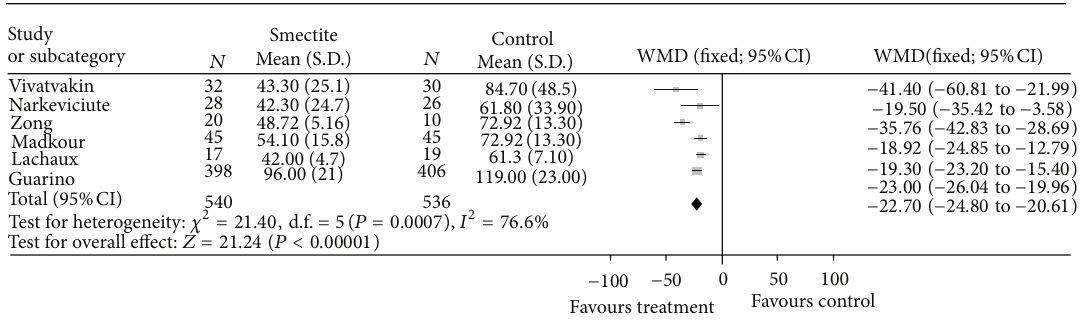
Figure 8: Mean duration of diarrhoea (h) in comparative randomised clinical studies of diosmectite. Reproduced from Szajewska et al. 2006 [70] with